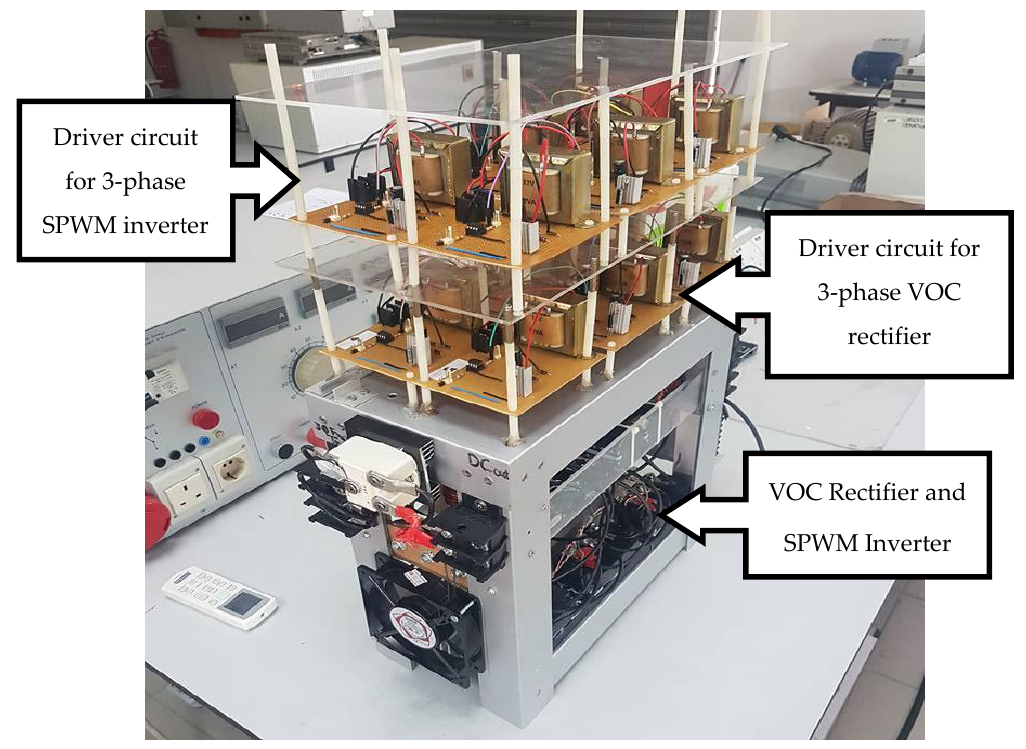
Figure 7. Experimental setup of EV universal charger circuits.